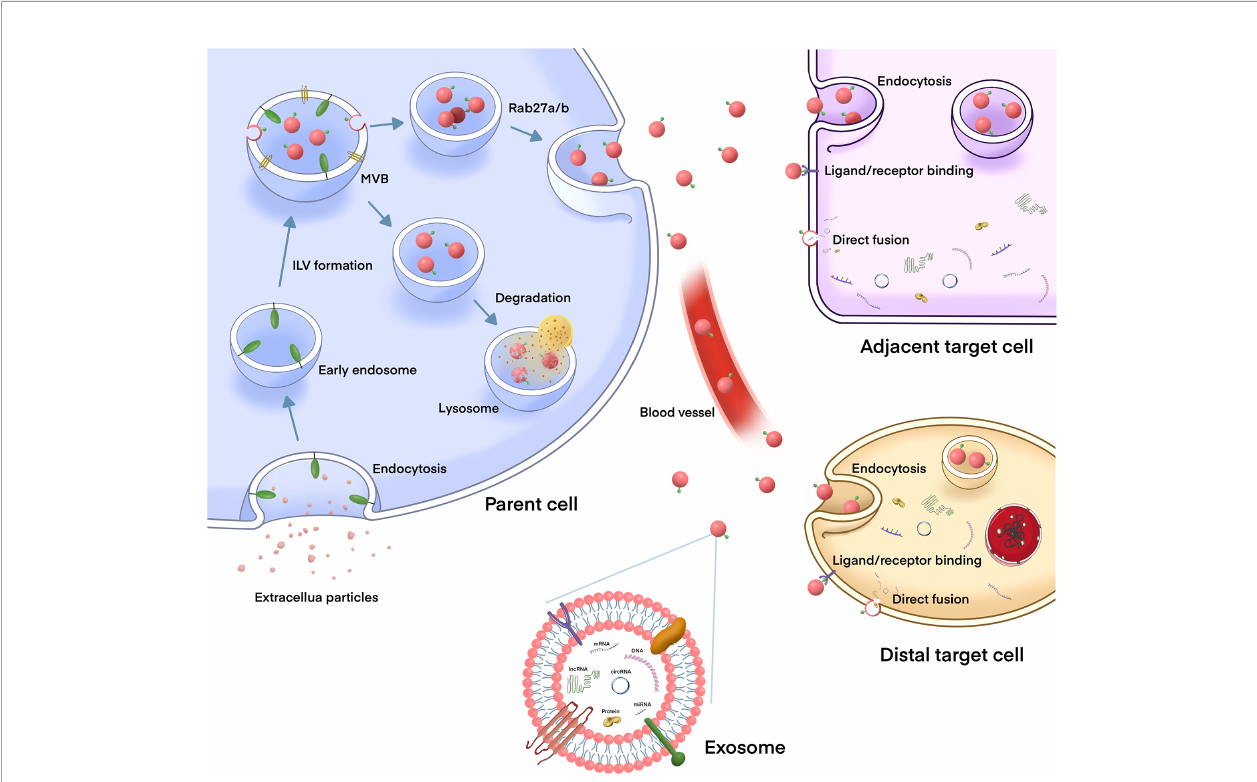
FIGURE 1 | The biogenesis and release of exosomes, and their role in intercellular communication. The biogenesis of exosome is initiated by the membrane invagination of early endosomes, and then form mature intracellular multivesicular bodies (MVBs), which organize intraluminal vesicles (ILVs) via endosomal sorting complex required for transport (ESCRT) dependent or independent pathways. MVBs can either fuse with lysosomes to degrade, or fuse with plasma membrane to release exosomes into the extracellular environment. After being released, the exosomes can play a biological role either locally or distant sites which is through the circulation. Exosomes are taken up by target cells in different mechanisms, such as endocytosis, direct fusion with the plasma membrane or ligand/ receptor interaction.Then, exosomes release their contents (including DNAs, proteins, mRNAs, miRNAs, lncRNAs, and circRNAs) to the recipient cells to regulate cell-to-cell